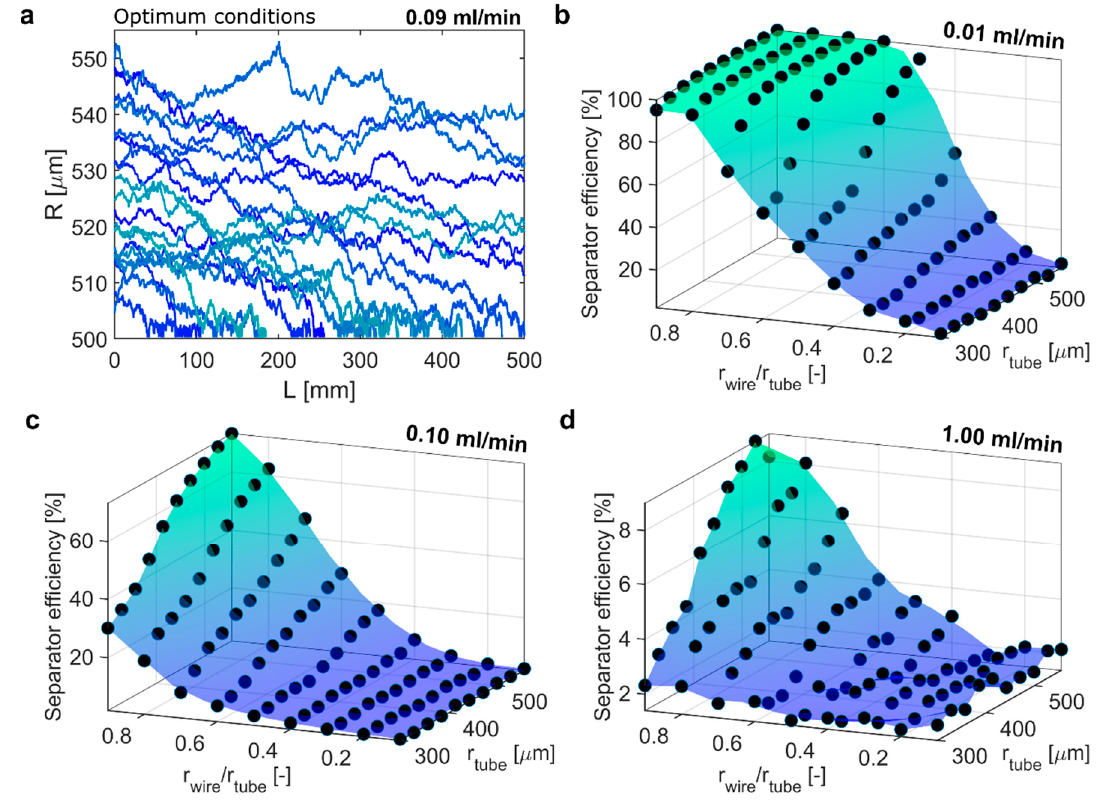
Figure 5. ( a ) 20 particle trajectories (out of 10,000) for the optimum separation condition for 250 nm MNPs yielding > 80% separator efficiency at 0.09 mL/min ( r tube = 555 µ m, r wire = 500 µ m, r wire / r tube = 0.9). Separator efficiency of 250 nm IONPs for different separator dimensions operated at ( b ) 0.01 mL/min, ( c ) 0.1 mL/min, and ( d ) 1 mL/min.